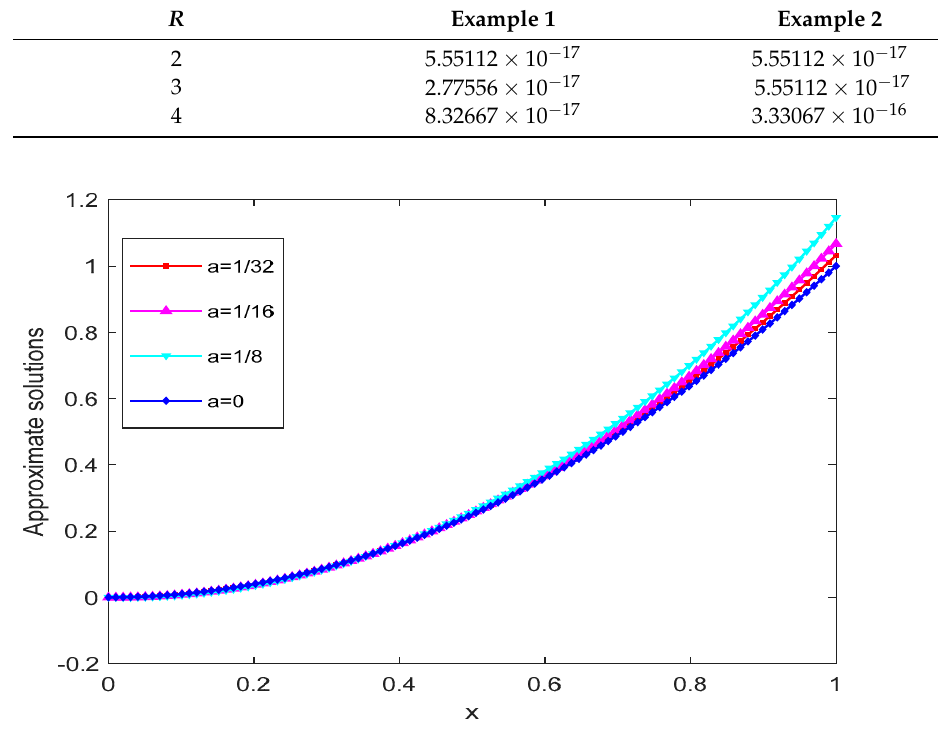
Figure 1. Plot of approximate solutions for different values of a and R = 2 for Example 1.